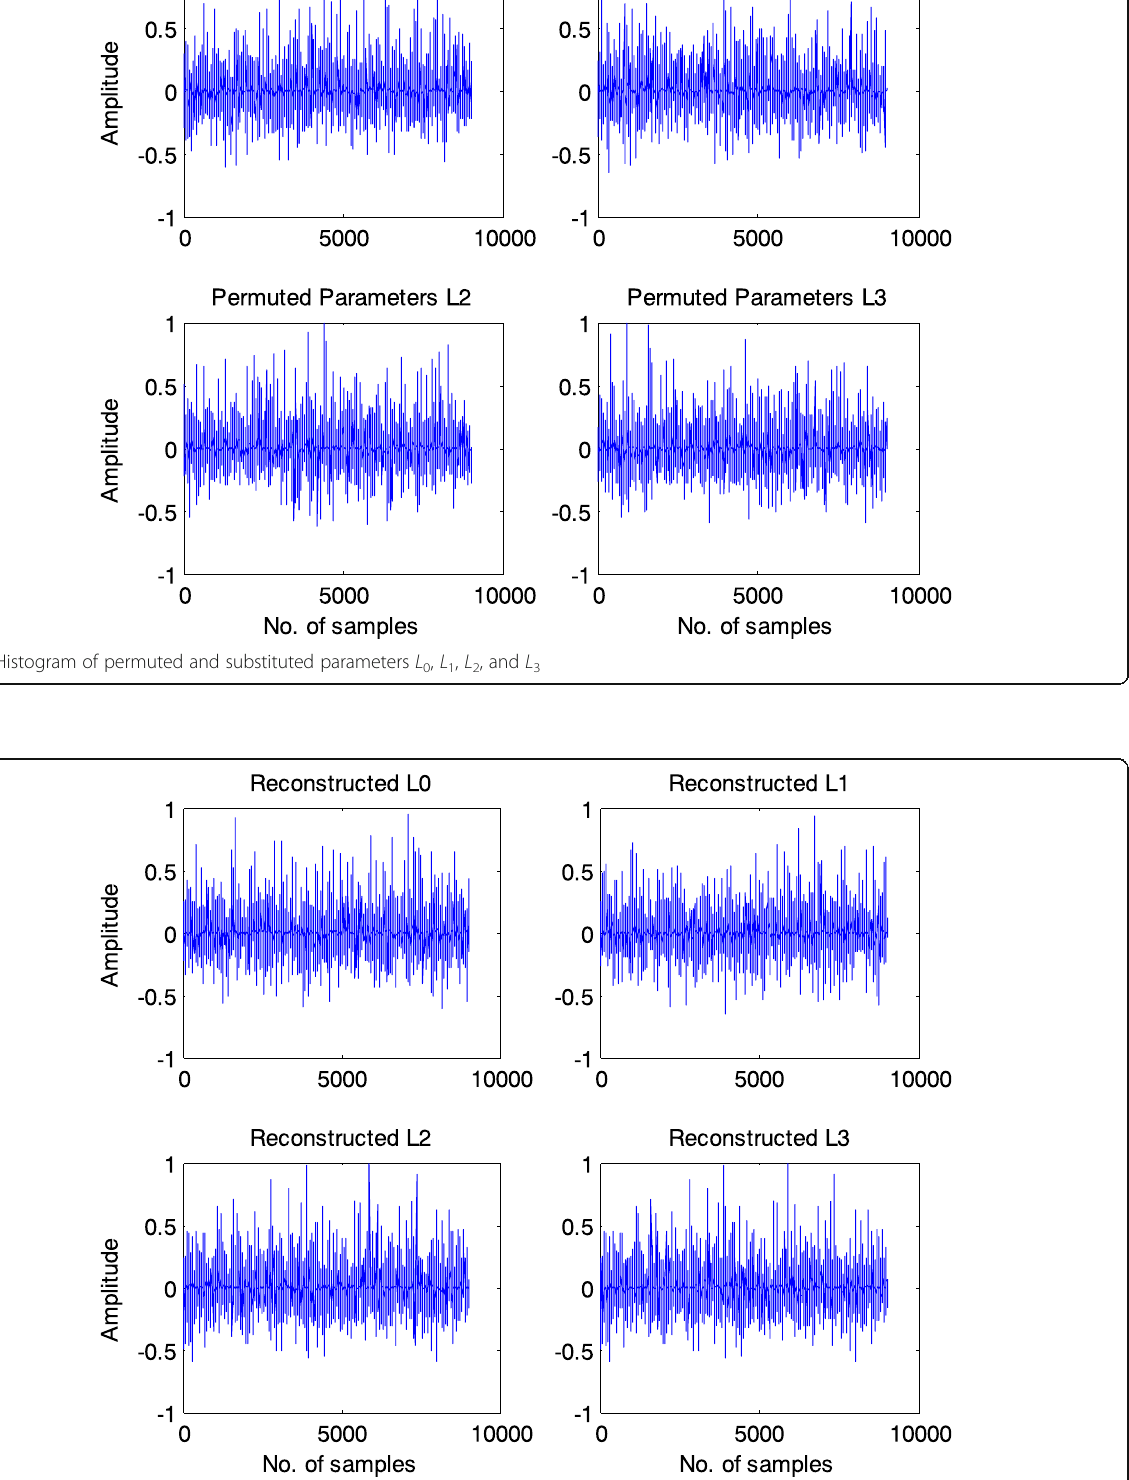
Fig. 7 Histogram of reconstructed parameters L 0 , L 1 , L 2 , and L